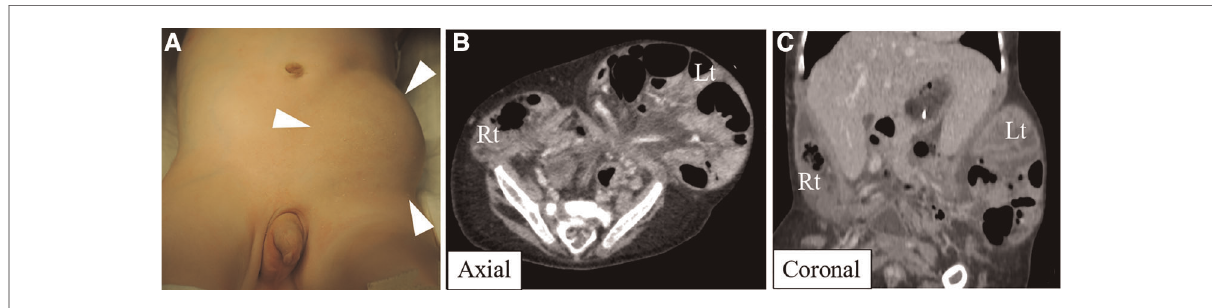
FIGURE 1 Physical examination revealed left fl ank swelling ( A ), and computed tomography revealed a bilateral inguinal hernia extending into both fl anks between the abdominal wall and the skin ( B,C